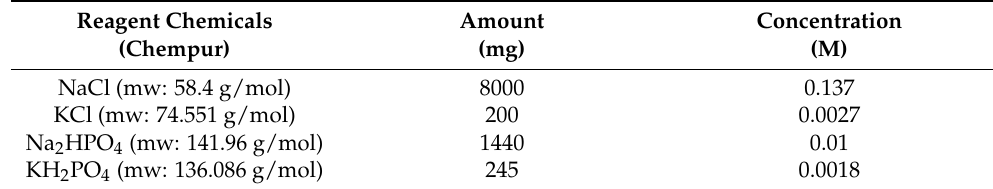
Table 2. The reagents used in the preparation of the buffer solution (PBS, pH